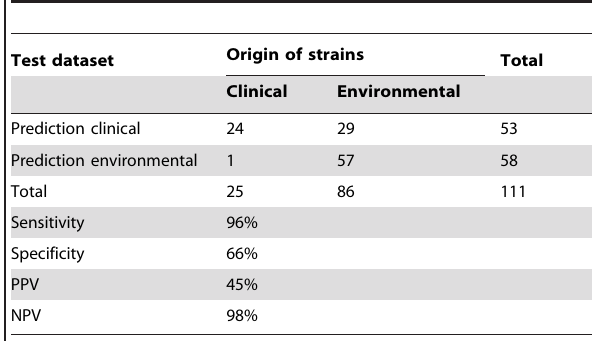
Table 2. Prediction results for the 111 strains in the eleventh test